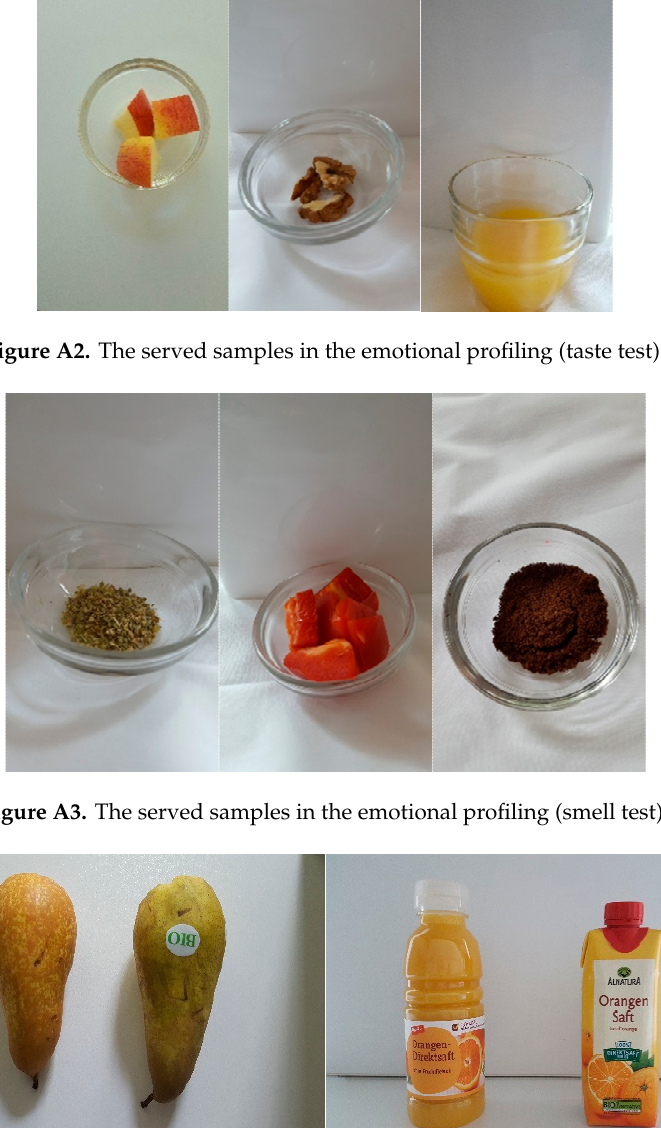
Figure A4. The served samples in the emotional profiling (visual Figure 4. The served samples in the emotional profiling (visual test). Figure 4. The served samples in the emotional profiling (visual test).